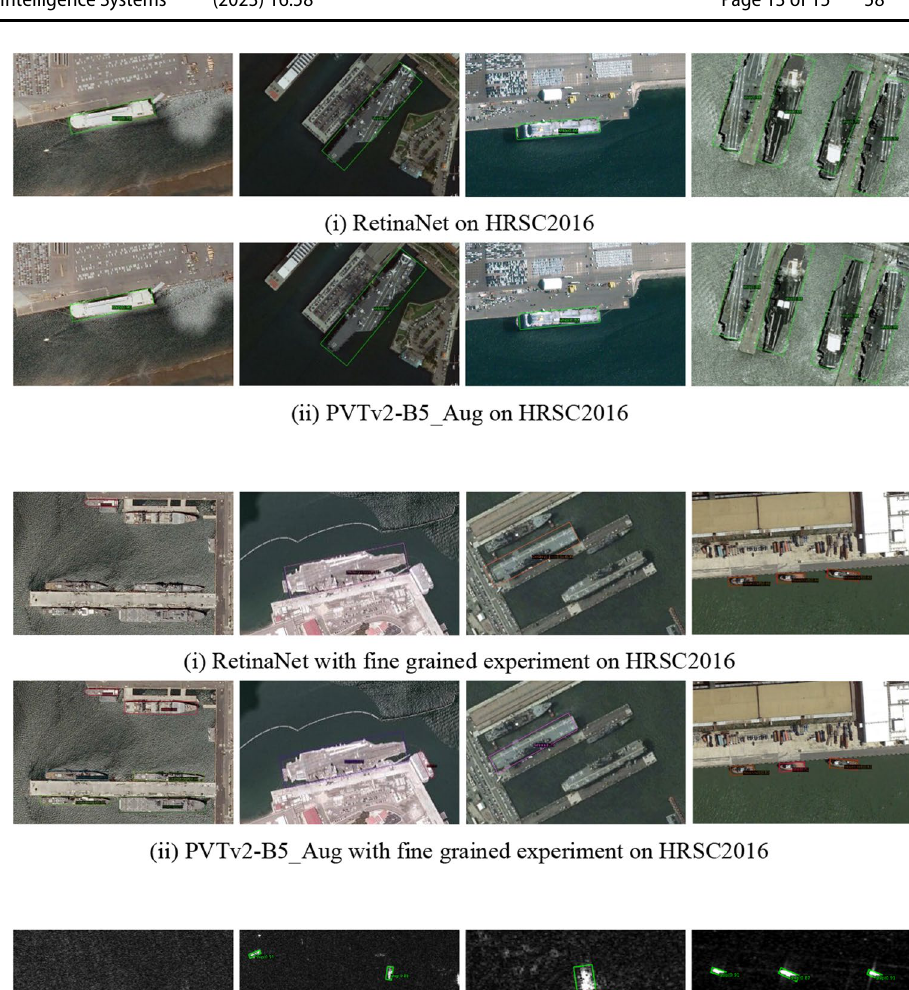
Fig. 9 Higher detection accu- racy of PVTv2-B5_Aug on HRSC2016